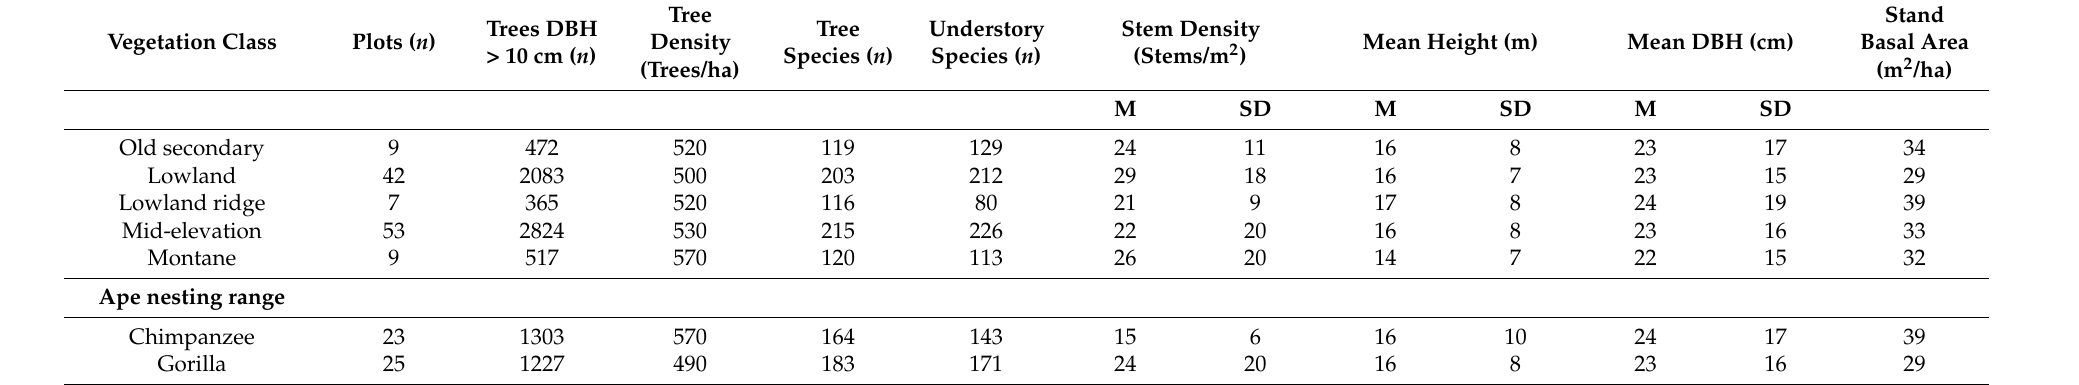
Table 5. Floristic characteristics from each vegetation class and ape nesting